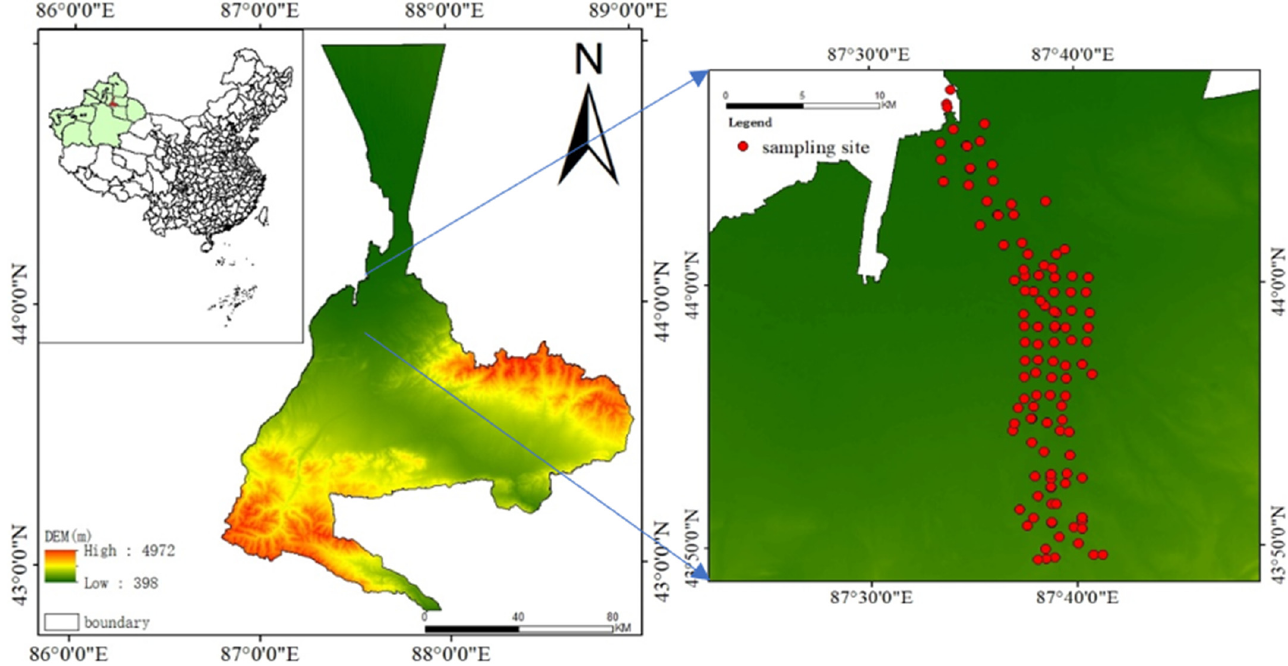
Figure 1. Distribution of sampling points.